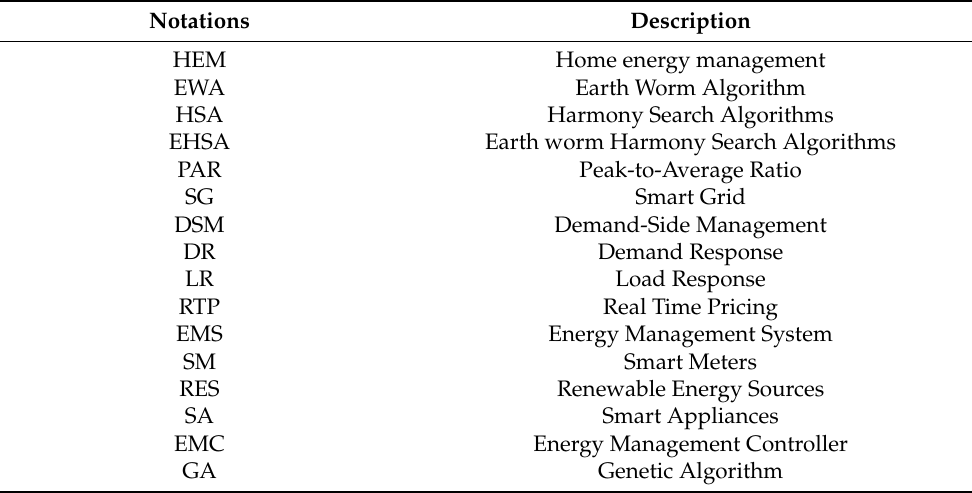
Table 1. Notation